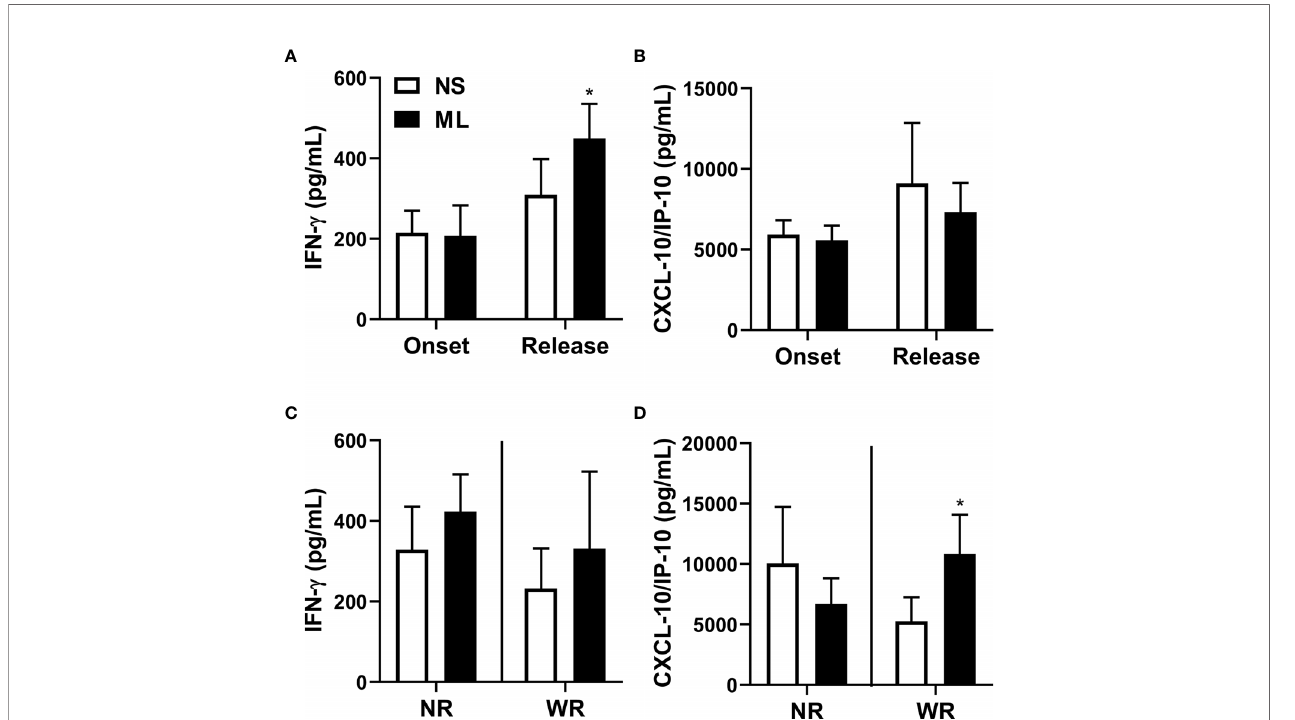
FIGURE 5 | Reduction in bacilloscopic index after 12-dose MDT is associated with increased production of CXCL10 (IP-10). Heparinized venous blood samples were collected at LL diagnosis (onset) and at completion of 12 doses of MDT (release). Whole blood was diluted in AIM-V media and stimulated (ML — stimulated with M. leprae ) or not (NS — non-stimulated) with 10 m g/mL sonicated M. leprae cell antigens for 5 days at 37°C 5% CO 2 . Levels of IFN- g and CXCL10 (IP-10) in the cell culture supernatants were evaluated by ELISA. (A, B) Graphs show: Average ± SEM of IFN- g (A) and CXCL10 (IP-10) (B) levels in culture supernatant at disease onset and MDT release. (C, D) Graphs show: Average ± SEM of the levels of IFN- g (C) and CXCL10 (IP-10) (D) at disease onset and at 12-dose MDT release, classi fi ed into two groups. The fi rst group contains patients who presented a reduction in the bacilloscopic index at release (WR, with reduction) and the second group comprises patients who did not reduce the bacilloscopic index after 12-dose MDT (NR, no reduction). *p ≤